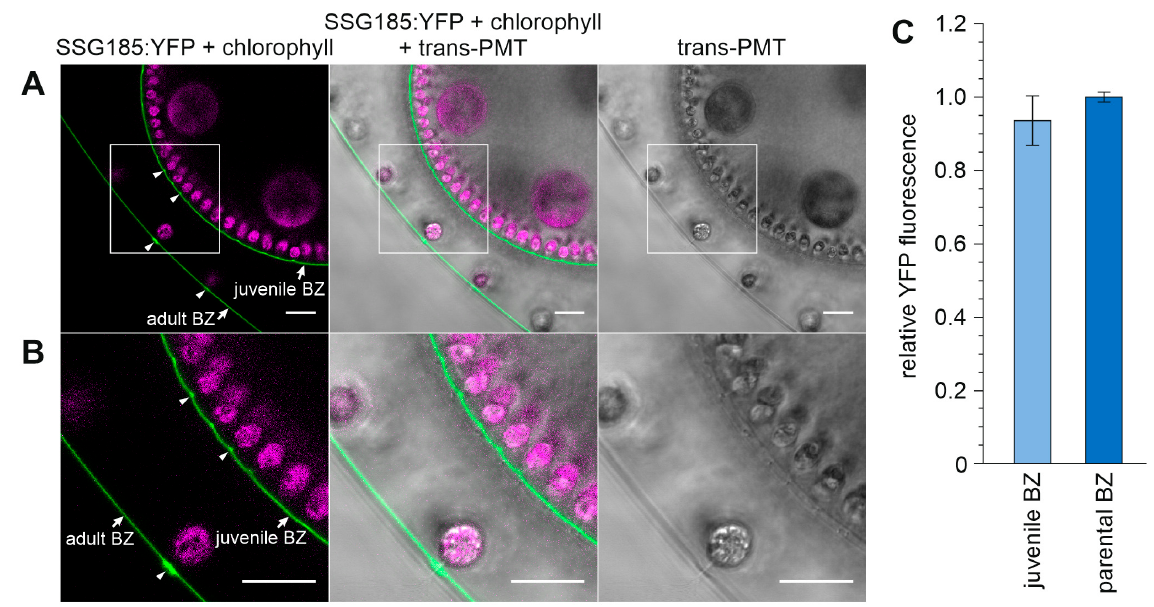
Figure 10. Localization of SSG185:YFP at the surface of juveniles shortly before hatching. Juveniles of transformants expressing the ssg185 : yfp gene were analyzed in vivo for the localization of the SSG185:YFP fusion protein. The juveniles are located inside their parental spheroid and their develop- mental stage is shortly before hatching. The boundary zones (BZ) both of the adult and the juvenile are indicated. Transmission-PMT (trans-PMT) images are included for orientation. ( A ) CLSM optical cross-section showing a part of an older adult with one of its juveniles inside. Note that the YFP signal intensity of SSG185:YFP in the adult BZ is similar to that in the juvenile BZ. Furthermore, the YFP signal can be found at the flagellar hillocks of both the adult and the juvenile (arrowheads). This becomes clearer in B. ( B ) Magnified detail of the framed area in A. Column 1: Overlay of YFP fluorescence of SSG185:YFP protein (green) and chlorophyll fluorescence (magenta). Column 2: Overlay of SSG185:YFP fluorescence (green), chlorophyll fluorescence (magenta) and transmission- PMT (trans-PMT). Column 3: Transmission-PMT alone. Scale bars: 15 μ m. ( C ) Comparison of the YFP fluorescence intensity in the BZ of juvenile algae shortly before release with the parental BZ. Fluorescence intensity was quantified in the YFP channel (520–550 nm) in a straight line spanning through the corresponding BZ and the maximal value was recorded. The recorded intensity values were normalized to the highest recorded value in order to exclude the influence of differing laser intensities between the replicates. The data represent three biological replicates with three technical replicates each. Error bars indicate standard deviation of the mean of the three biological replicates.